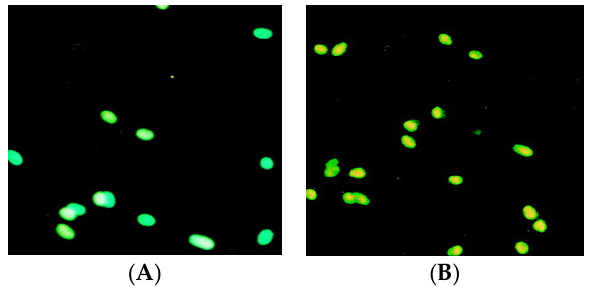
Figure 3. MDA-MB-231 cells with the IC 50 concentration of compound and control drug (0.4 and 3.74 nM). After 48 h: ( A ) treated cells with erlotinib; ( B ) treated cells with ( 6c ) compound displaying the apoptotic effect on the cells. Green color indicates normal cell and yellow color indicates apoptotic cell.